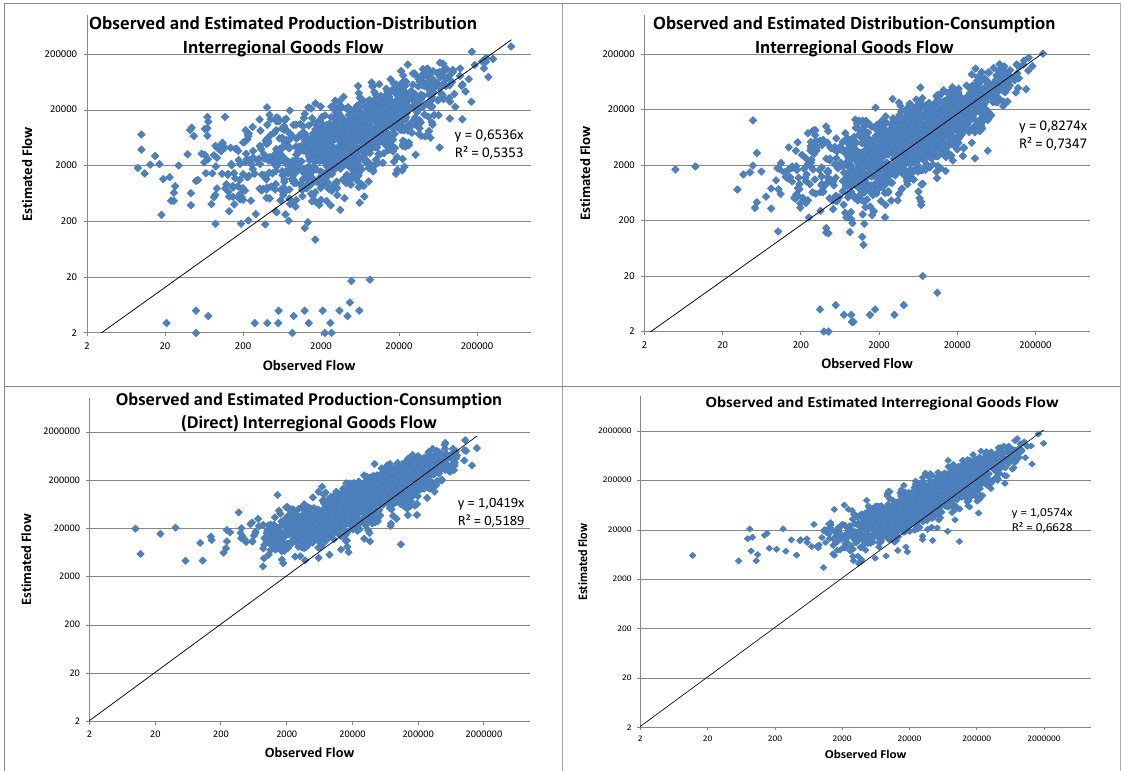
Figure 2. Comparison of estimated and observed flows in calibrated model To demonstrate model performance at the regional level we also present an earlier published (Davydenko and Tavasszy, 2013) calibration result with respect to the annual regional warehouse throughput, Figure 3. The annual warehouse throughput is computed as the sum of all incoming and outgoing ton volumes through distribution facility per NUTS3 region. At this level the model shows an accurate (R 2 = 0,947) representation of the observed regional distribution volumes